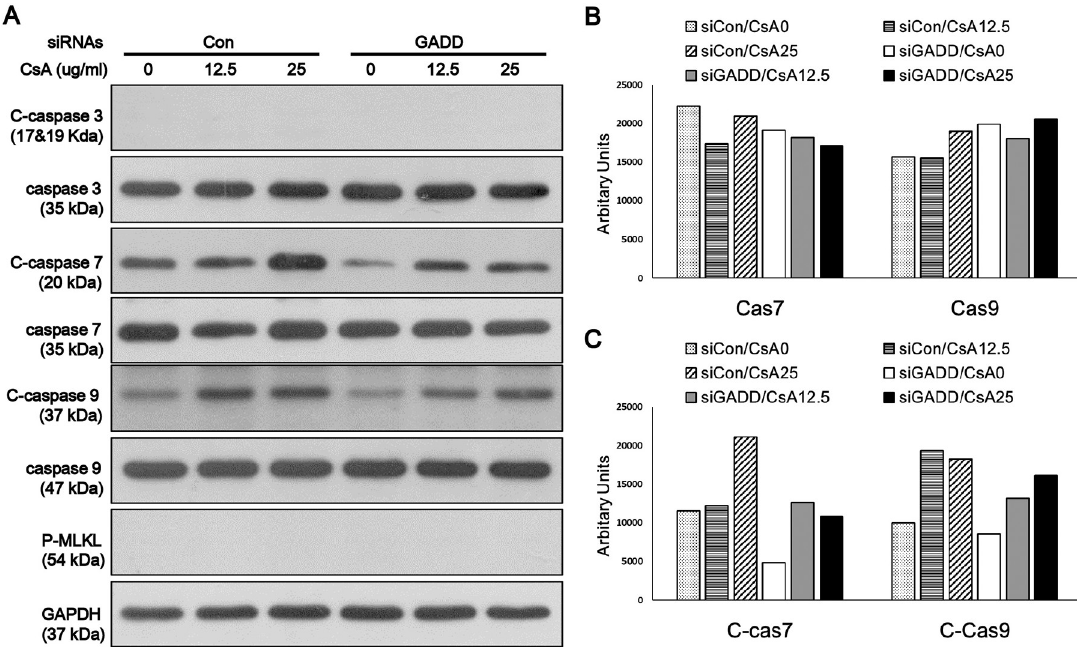
Fig 13. Westernblot analysis of caspase activation in HK-2cells: Effect of silencing of GADD45G. HK-2 cells weretransfectedwith siRNAsfor 24 hours,and then treatedwith 12.5 μ g/mland 25 μ g/mlCSA for 24 hours to harvest proteinfor westernblotting (A). Quantification of western blots was performed using Image J for caspase7 and caspase9 (B) ,and C-caspase 7and C-caspase 9 (C) .C-caspases representcleaved(active)-caspases; siRNAGADD, siRNAtargetingGADD45G;siRNA Con,controlsiRNA targetingno known genes. https://doi.org/10.1371/journal.pone.0260135.g013 PLOS ONE | https://doi.org/10.1371/journal.pone.0260135 November17,